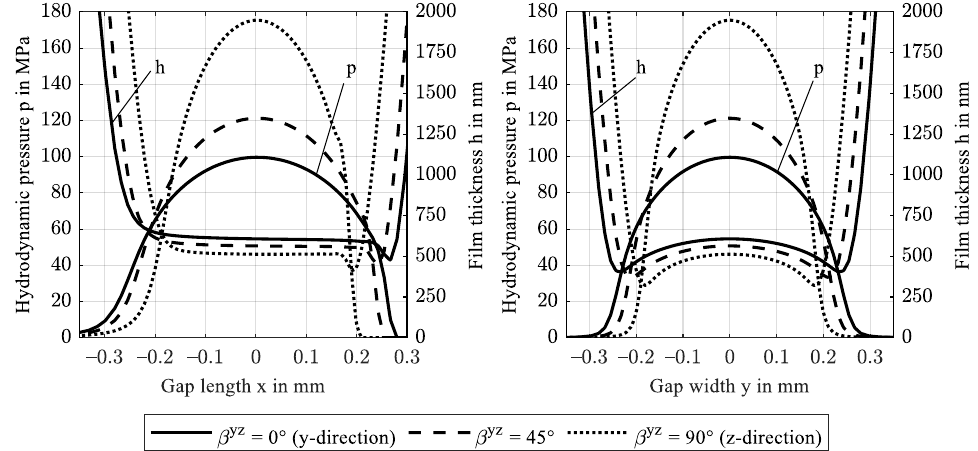
Figure 14. Hydrodynamic pressure p and film thickness h profiles along the gap length x at y = 0 ( left ) and along the gap width y at x = 0 ( right ) for rotation 𝛽 𝑦𝑧 of fiber orientation in the yz- plane.